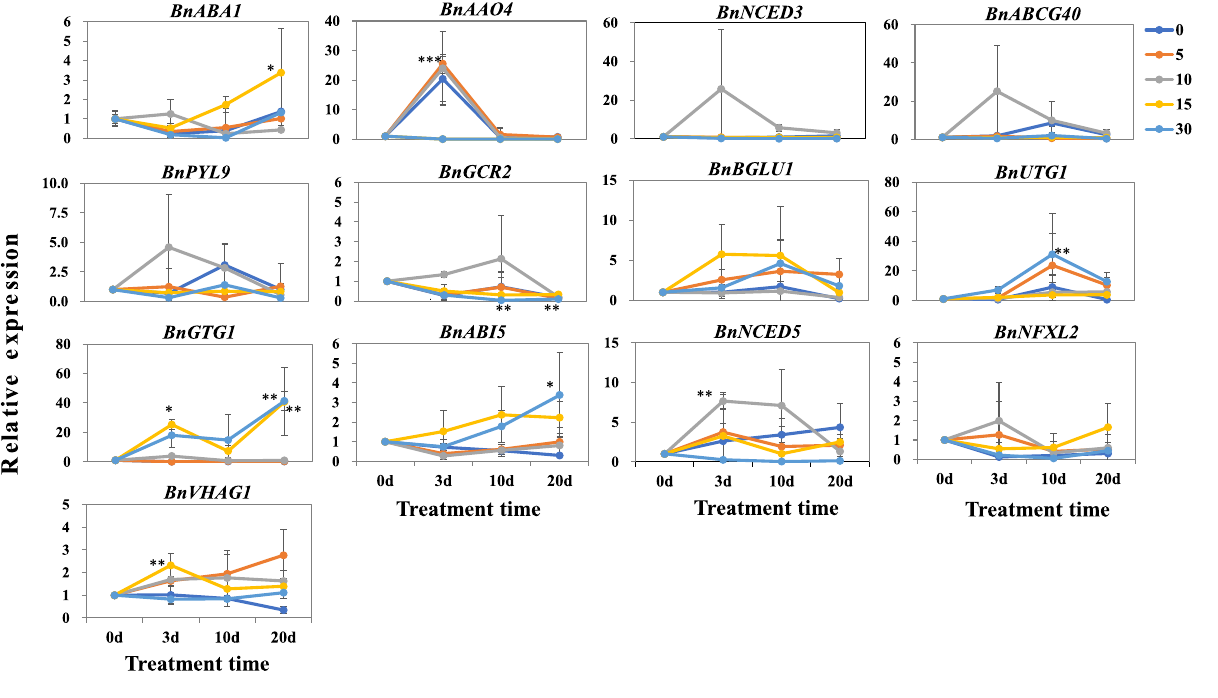
Figure 4. Relative expression of the ABA synthesis related genes ( BnABA1 , BnNCED3 , BnNCED5 and BnAAO4 ) and the genes ( BnABCG40 , BnNFXL2 , BnPYL9 , BnGCR2 , BnGTG1 , BnBGLU1 , BnUTG1 , BnVHAG1 and BnABI5 ) encoding ABA transport and response proteins in leaves of ramie under Cd stress. The 2 −ΔΔCt method was used to calculate the relative expression of the selected genes. Data are means ± SD of three biological replicates. Each replicate consisted of material from ten plants. 0, 5, 10, 15 and 30 denote the CdCl 2 concentration (mg L −1 ). *, ** and ***denote statistically significant differences from the control (samples collected before Cd treatment, 0 d) at P < 0.05, P < 0.01 and P < 0.001,